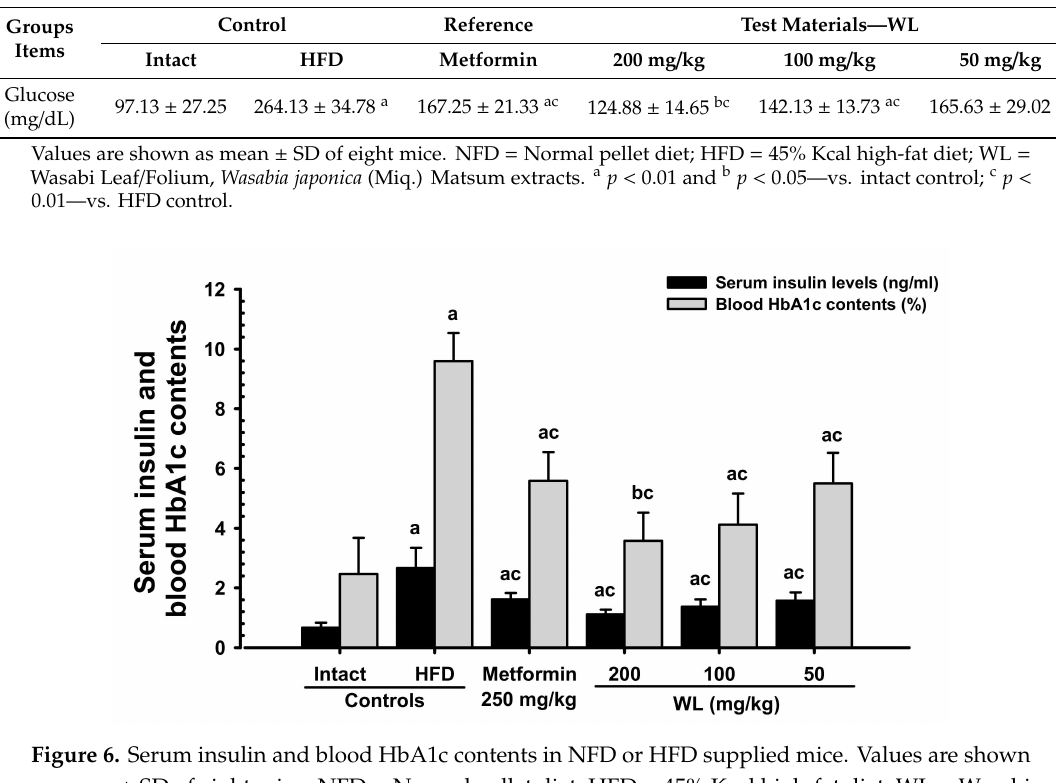
A1c. a p < 0.01 and b p < 0.05—vs. intact control; c p < 0.01—vs. HFD